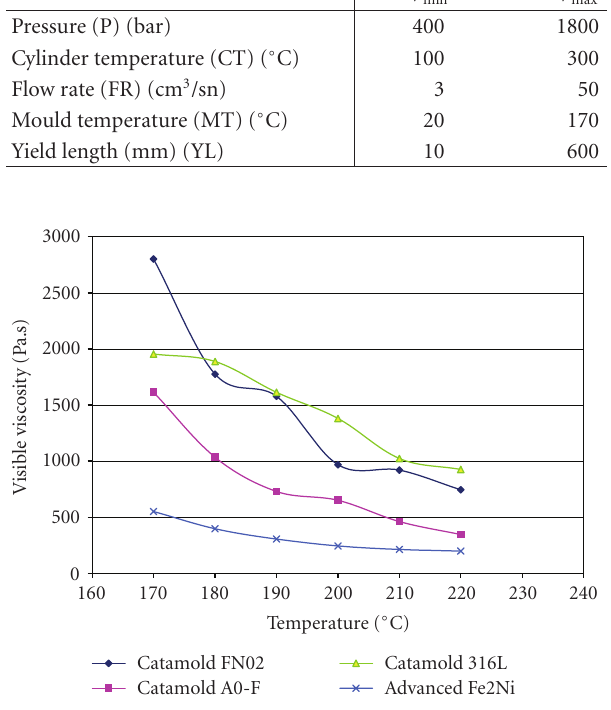
Figure 7: Temperature versus visible viscosity for present feedstocks (load 1,878